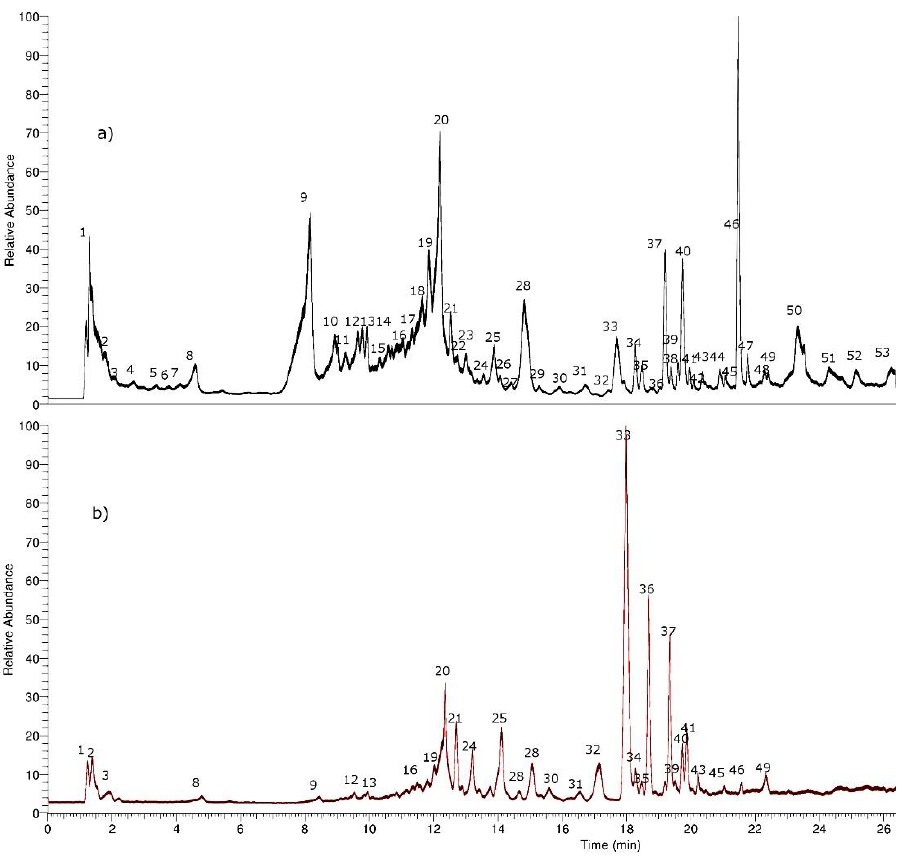
Figure 2. Total ion current (TIC) chromatograms of H. taltalense : ( a ) methanolic extract and ( b ) aqueous extract.